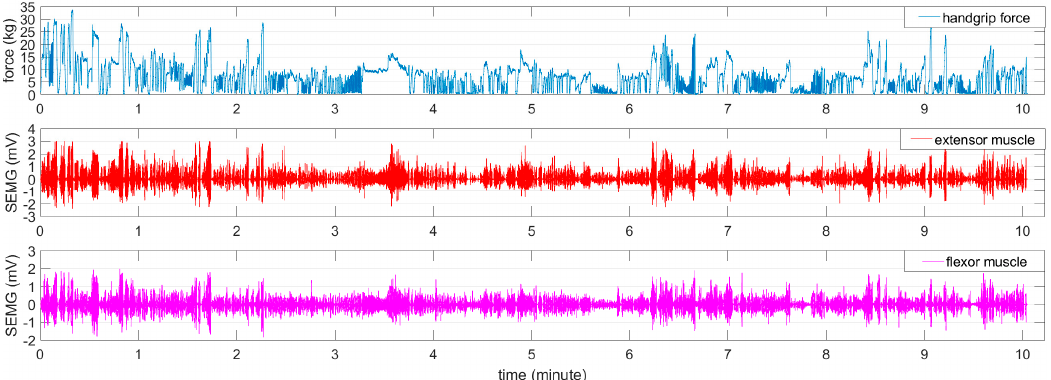
Figure 3. The process of the force-varying validation task.